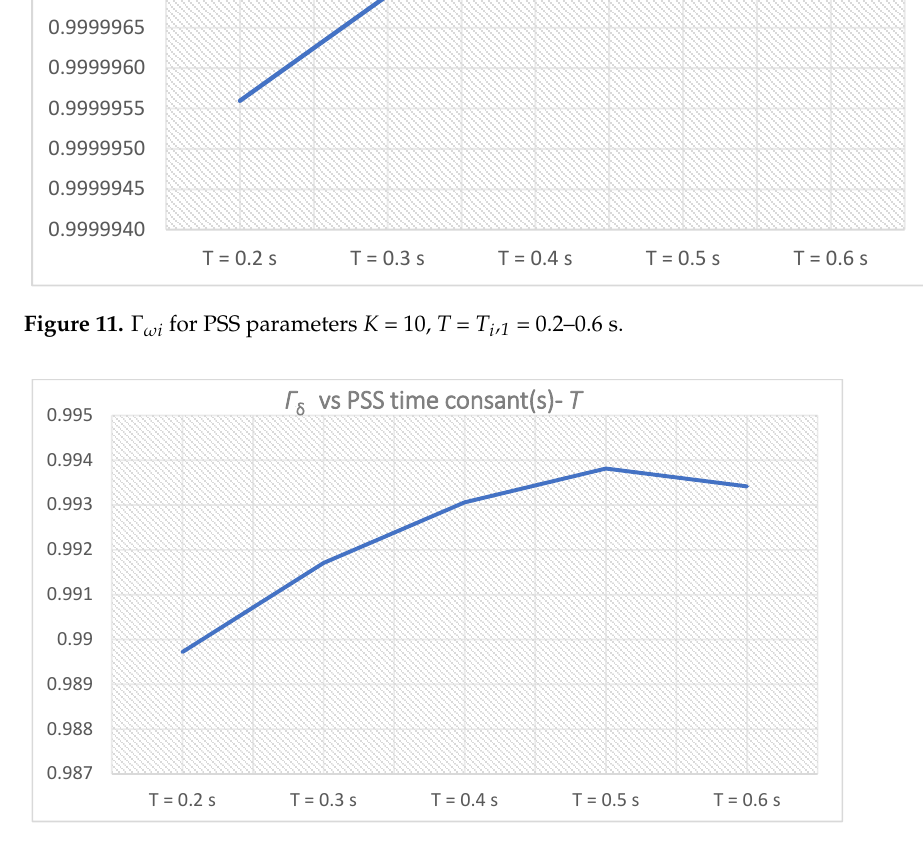
Figure 10. Γ ζi for PSS parameters K = 10, T = T i, 1 = 0.2 – 0.6 s.